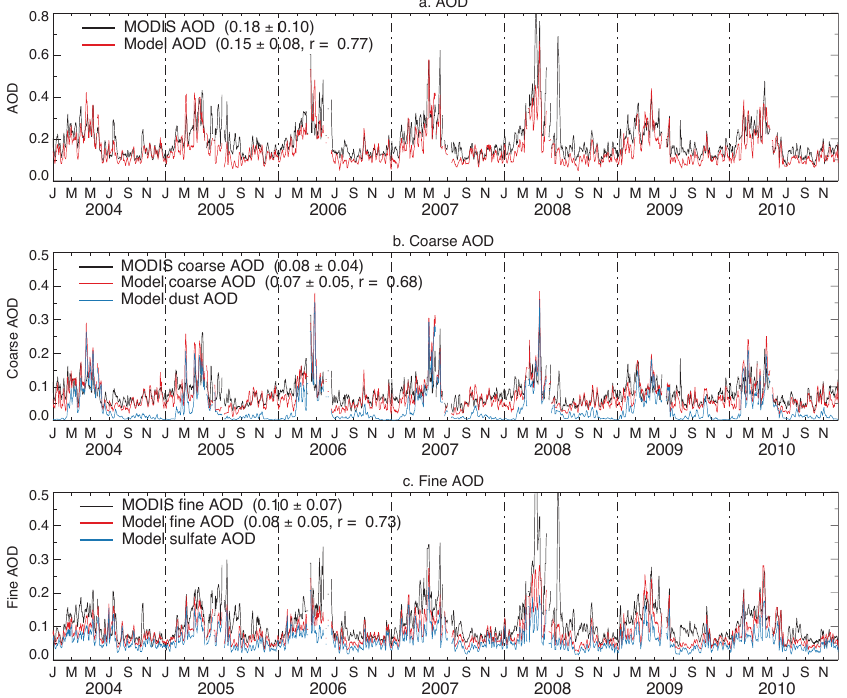
Fig. 2. Daily timeseries of AOD in the Asian outflow region (145 ◦ –155 ◦ E, 30 ◦ –50 ◦ N, white box in Fig. 1) for 2004–2010: (a) total AOD, (b) coarse AOD, (c) fine AOD. MODIS AOD is shown in black and GEOS-Chem AOD in red. In addition, modeled dust AOD is shown in panel b (blue line) and modeled sulfate in panel c (blue line). A 5-day running mean was applied to the daily AOD for both MODIS and